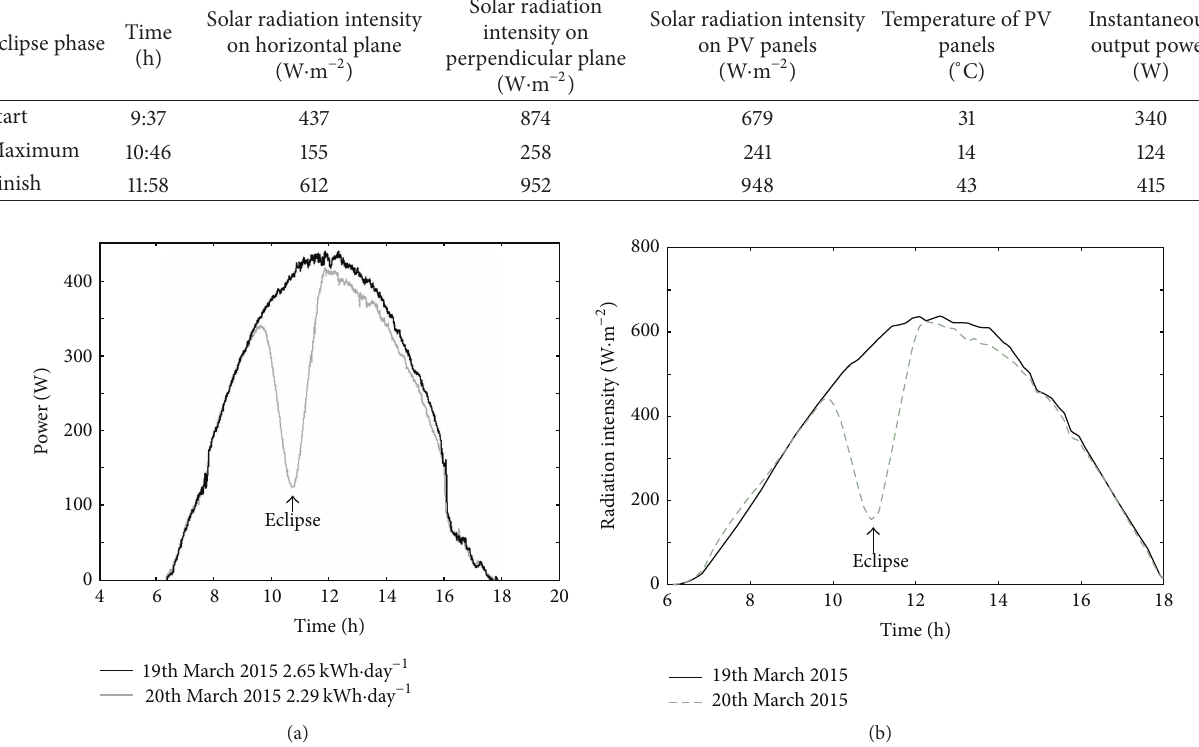
Figure 3: (a) Time series of instantaneous output power and the amount of generated electric energy and (b) time series of solar radiation intensity incident on a horizontal plane, during two sunny days (19th to 20th March